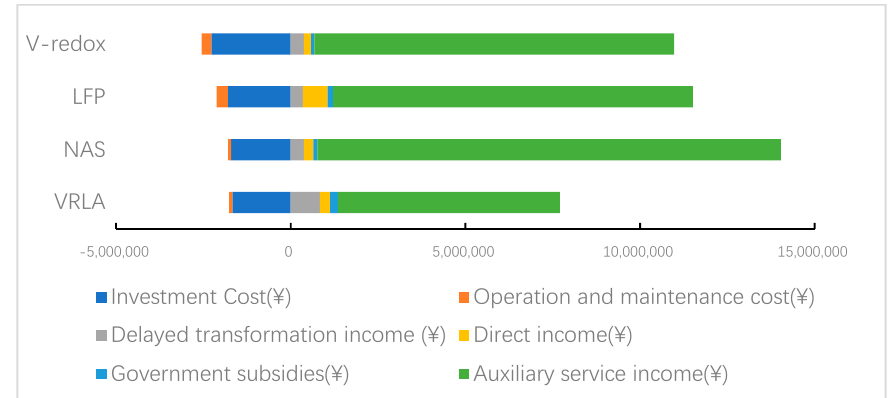
Figure 1. Each cost and income term of demand management with four different energy storage batteries. VRLA: valve regulated lead acid, NAS, LFP: LiFePO4, V-redox: Vanadium Redox.